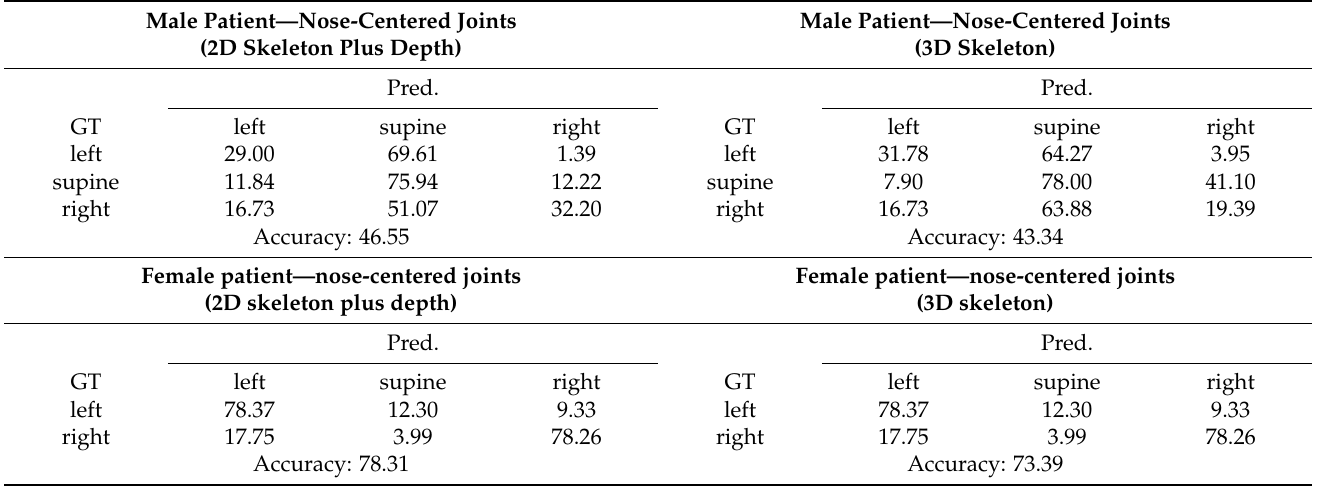
Table 5. Accuracy and confusion matrix (all numbers in terms of %) for Setting 2.